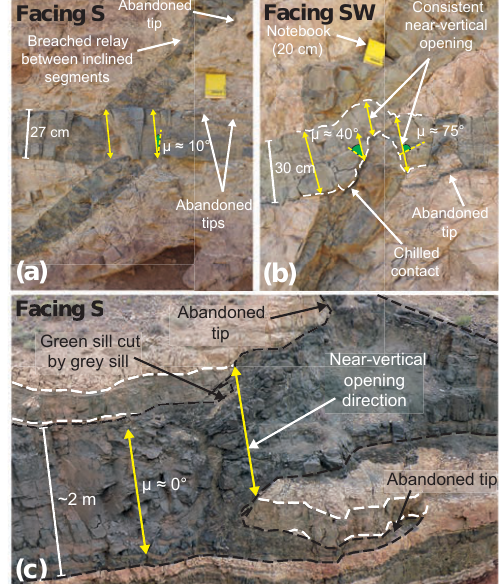
Figure 6. Sill–sill cross-cutting relationships. (a) Younger horizon- tal sill maintains a constant thickness when cutting older sill. (b– c) Inclined sill sections are thinner than horizontal sections. All sills show near-vertical opening directions, regardless of